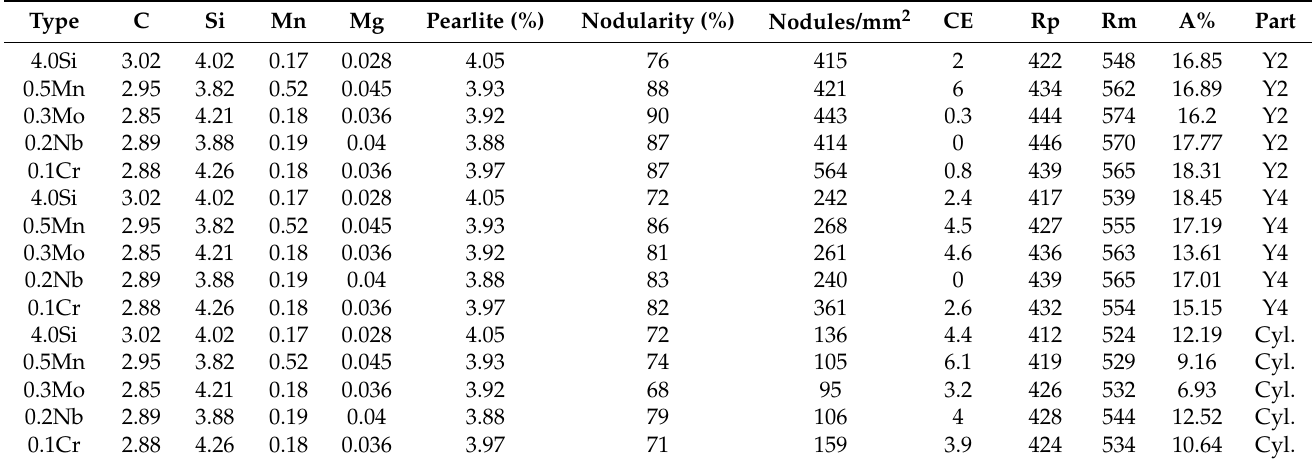
Table 4. Summary of alloying trails on EN-GJS-500-14. Adapted from